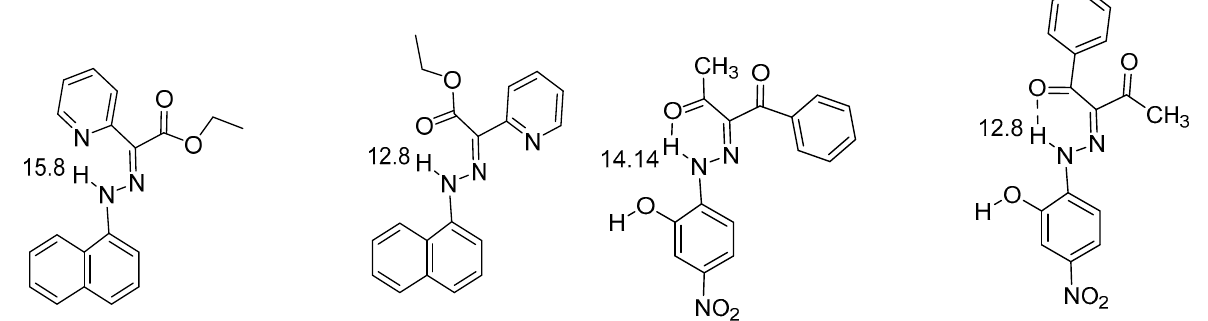
Figure 10. Comparison of rotamers. The numbers are NH chemical shifts in ppm. The chemical shifts are from [36]. The NH chemical shifts for the corresponding benzene derivative (benzene instead of naphthalene) are 14.6 ppm instead of 15.8 ppm. [34] If the ring is a 8 ‐ benzoquinoline the chemical shift is 15.36 ppm [37].